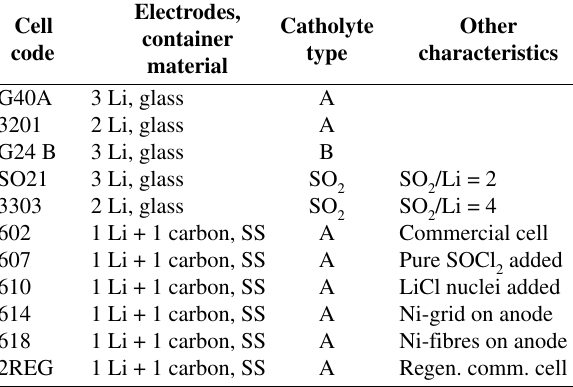
Table 1. Overview of the cell data. The area of the Li (working) electrodes varies between 20 and 27 cm 2 . The exact value is given where needed.